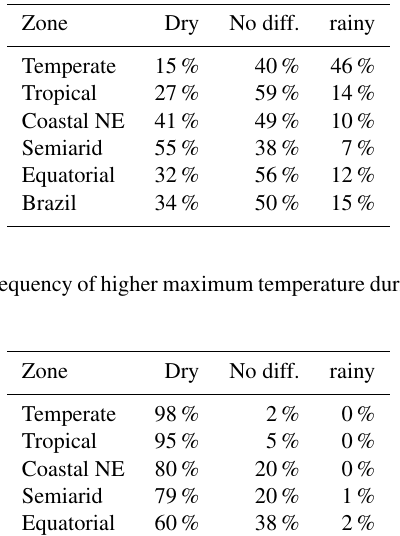
Table 1. Frequency of stronger wind during dry and rainy days.